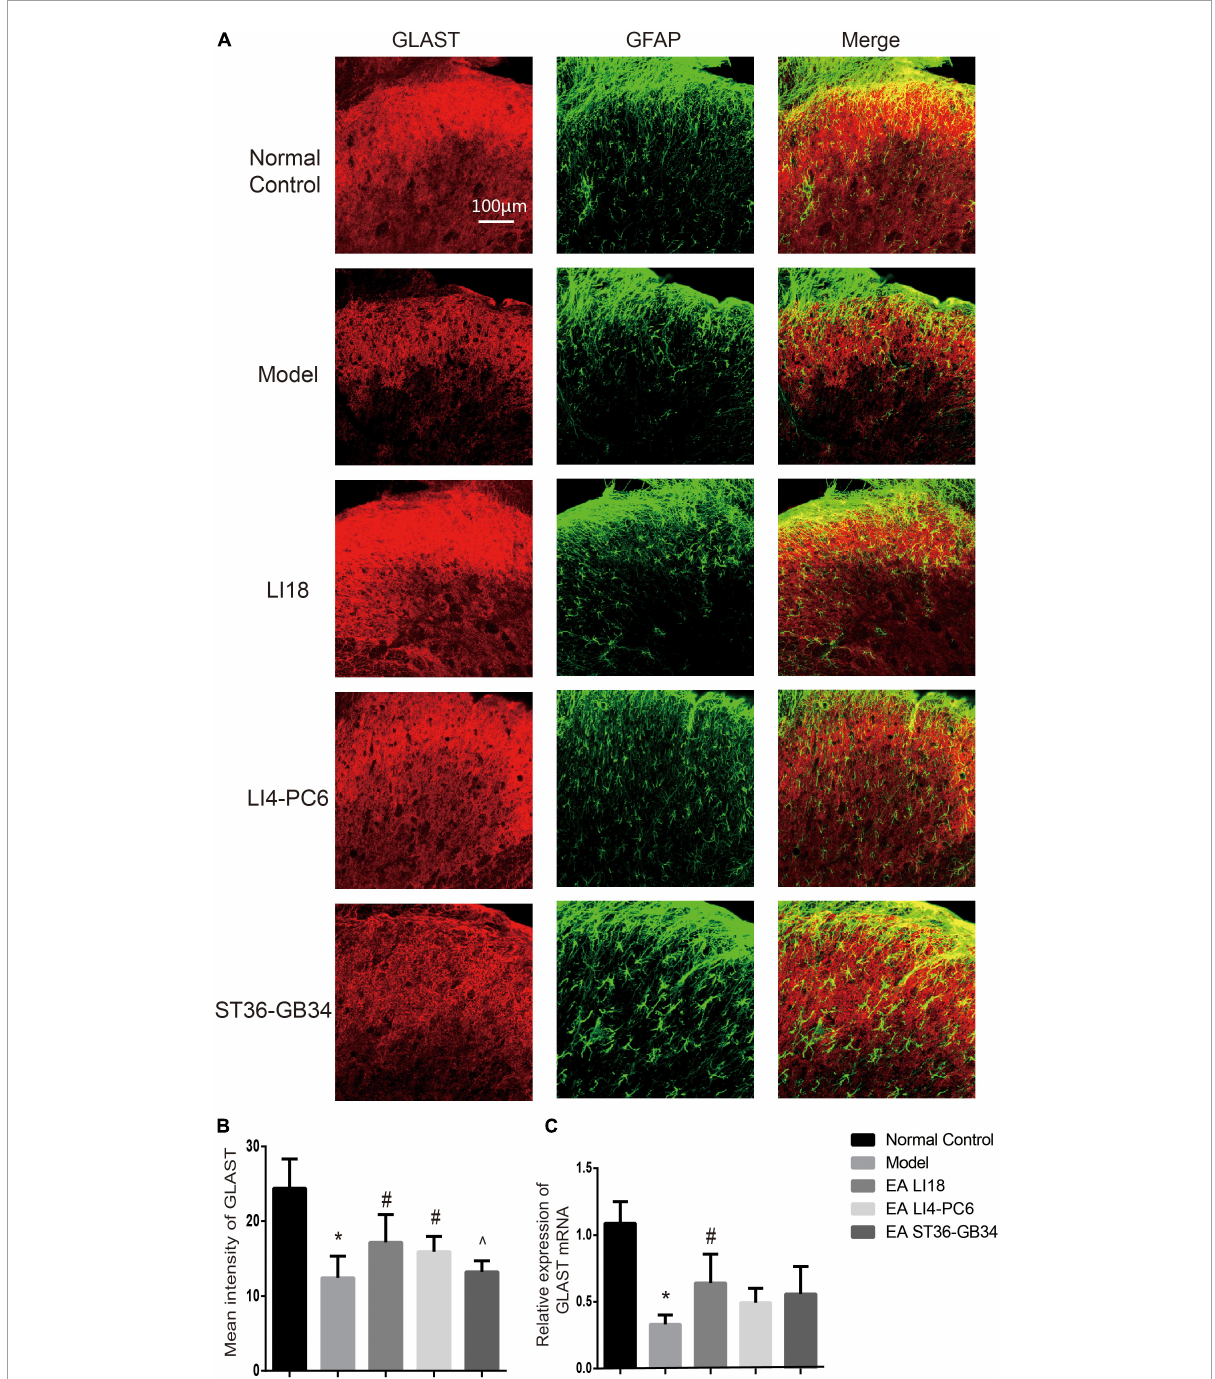
FIGURE7 Comparison of expression of glu aspartate transporter (GLAST) in different groups (mean ± SD, n = 6/group). (A) Fluorescence micrographs of immunohistochemistry staining showing the co-expression (yellow) of GLAST (red) and glial fibrillary acidic protein (GFAP) (green) in the cervical spinal cord dorsal horns (DHs) at 24 h after neck incision. The scale bar is 100 µ m. (B) Bar graphs showing the mean fluorescence intensity of GLAST in the five groups. The expression of GLAST protein was reduced in the model group relevant to the control group. After electroacupuncture (EA), the expression level of GLAST protein was significantly upregulated in both EA LI18 and EA PC6-LI4 groups but not in the EA ST36-GB32 group. (C) Bar graphs showing the relative expression of GLAST mRNA in the five groups. The expression of GLAST mRNA was significantly downregulated in the model group (vs. the control group) and significantly increased in EA LI18 group, rather than in the EA PC6-LI4 and EA ST36-GB34 groups (vs. the model group). * P < 0.01, vs. the control group, # P < 0.05, vs. the model group, ˆ P < 0.05, vs. the EA LI18